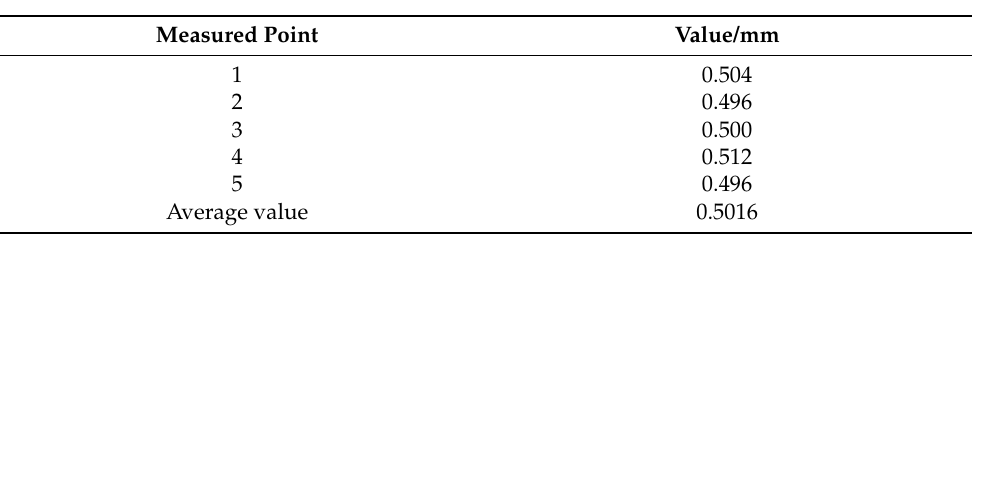
Table 3. Charge width data of 0.5